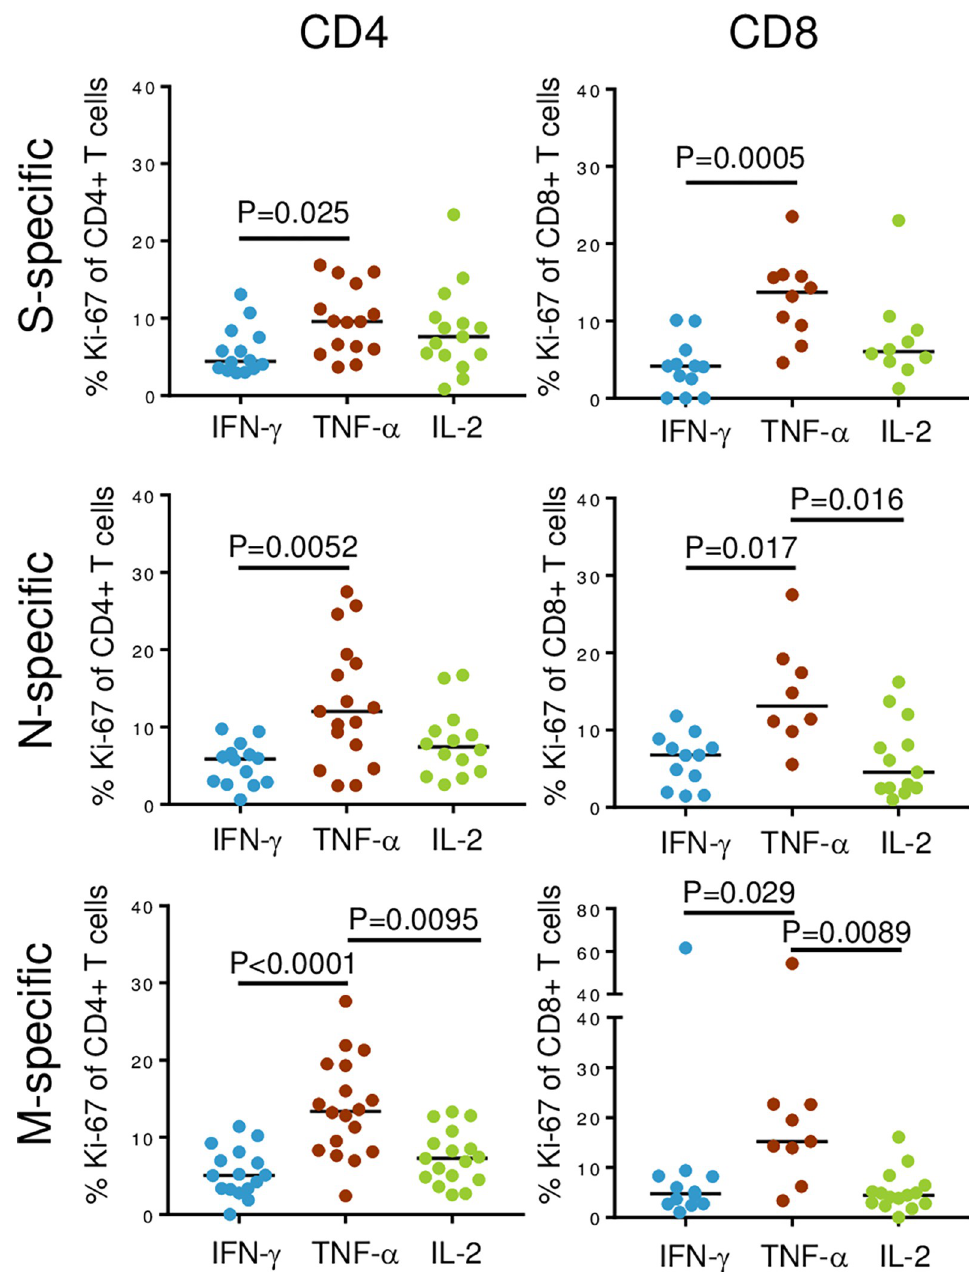
Fig 3. TNF- α -producing T cells have the highest proportion of Ki-67 expression. The percentages of Ki67 expressing SARS-CoV-2-specific CD4 + (left panels) and CD8 + (right panels) T cells obtained from the blood of PASC participants are shown. SARS-CoV-2 S- (top panel), N- (middle panel) and M- (bottom panel) specific T cells are grouped by production of IFN- γ , TNF- α and IL-2. Note, data points from individual PASC participants were obtained for 1 or more of the cytokines assessed; however, in no instances are there multiple values obtained from the same participant for a particular cytokine. Blue represents IFN- γ + T cells, brown represents TNF- α + T cells and green represents IL-2 + T cells. Kruskal-Wallis tests with corrections for multiple comparisons were used to determine statistical significance.